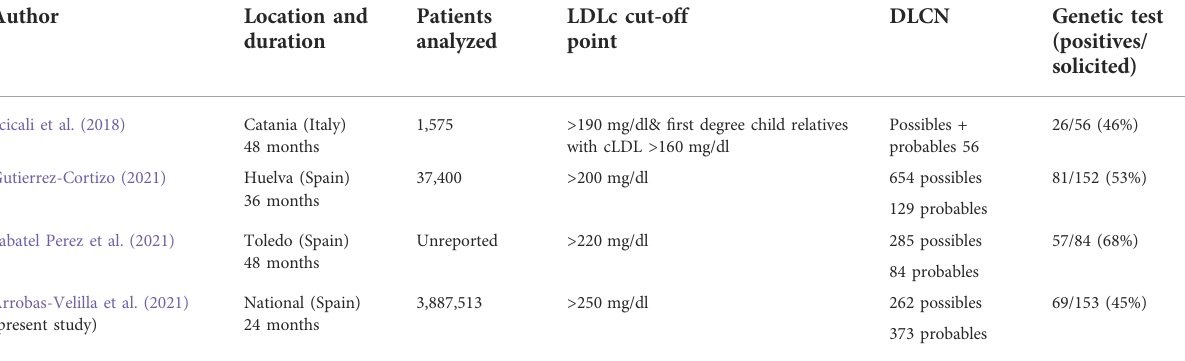
TABLE 2 Screening for Familial Hypercholesterolemia using centralized laboratory